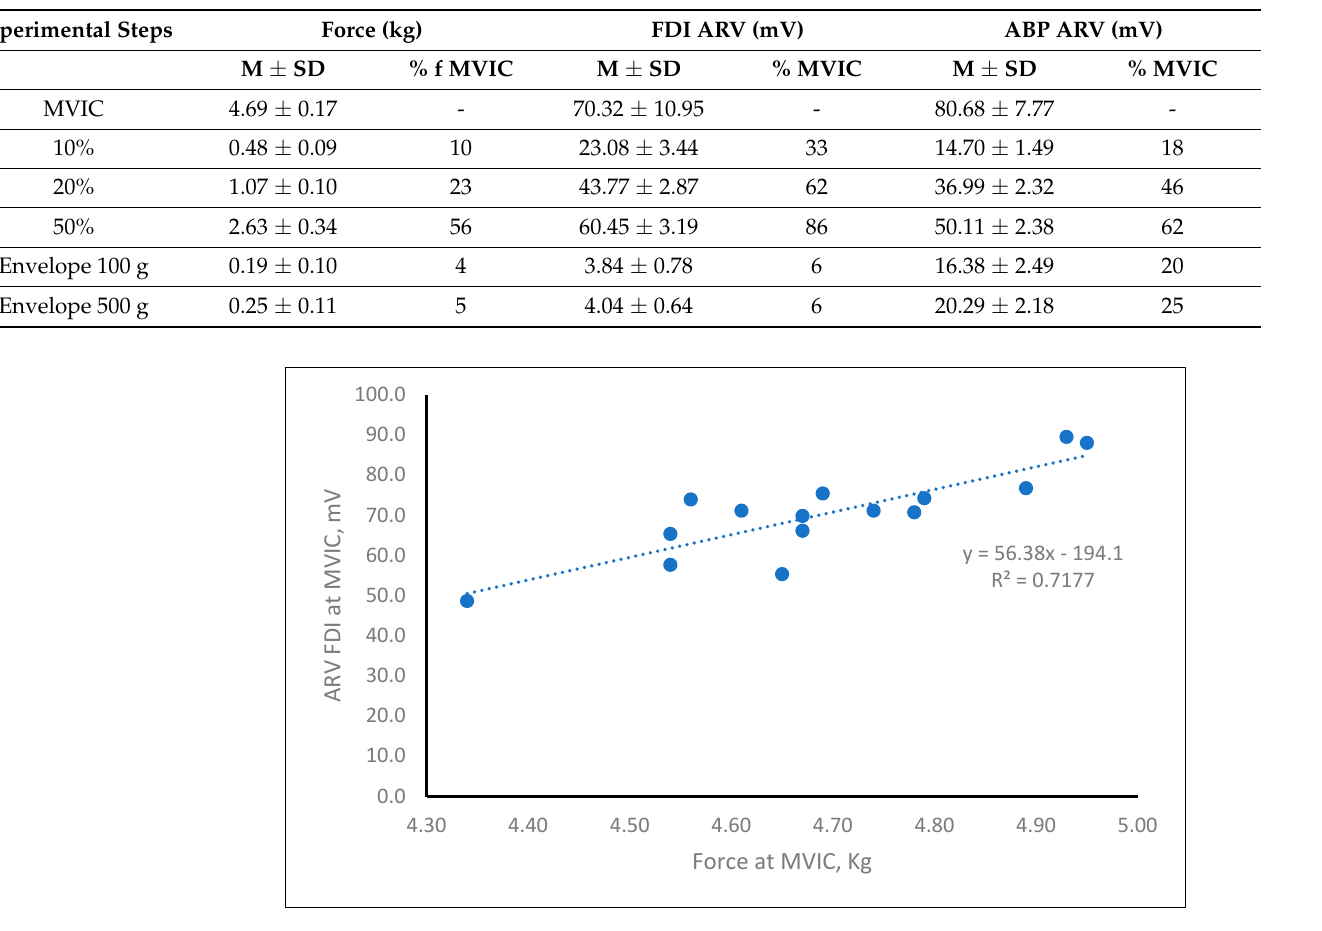
Figure 2. Regression between force and ARV FDI values at MVIC in the enrolled workers. No sex differences in ARV values or in force were observed, and no relationship was apparent between ARV and age, with the exception of ABP ARV at MVIC ( p = 0.0468 for 100% MVIC).